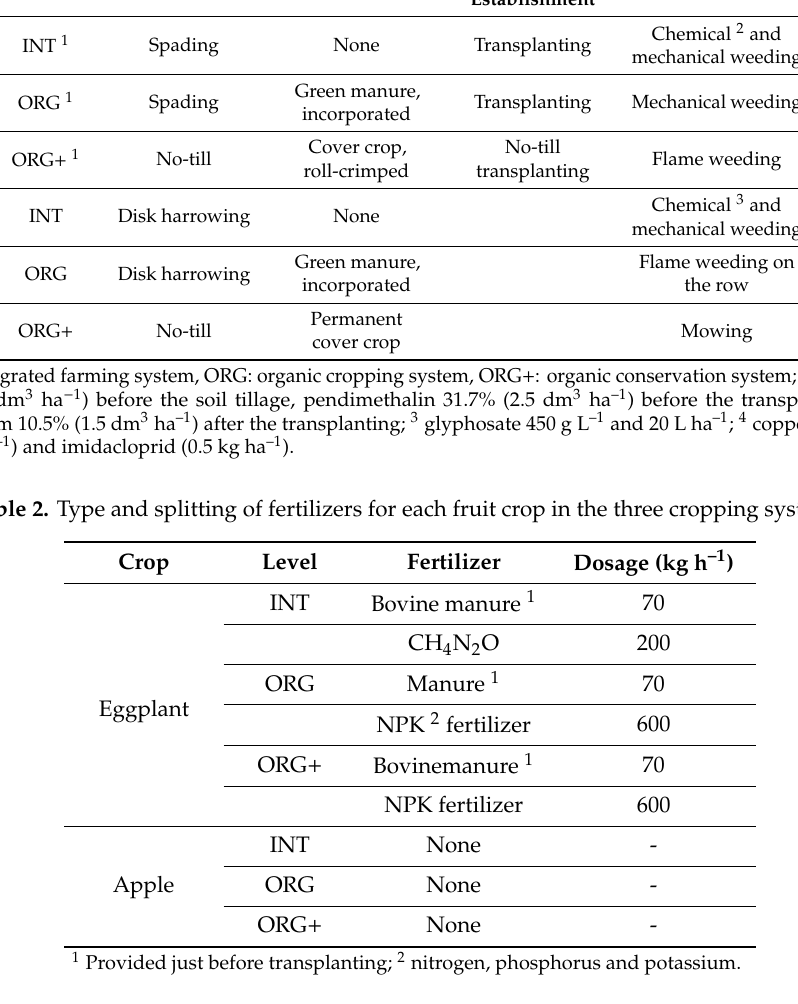
Table 1. Agricultural practices carried out for each fruit crop in the three cropping systems. Crop Level Main Tillage Cover Cropping INT 1 Spading Eggplant